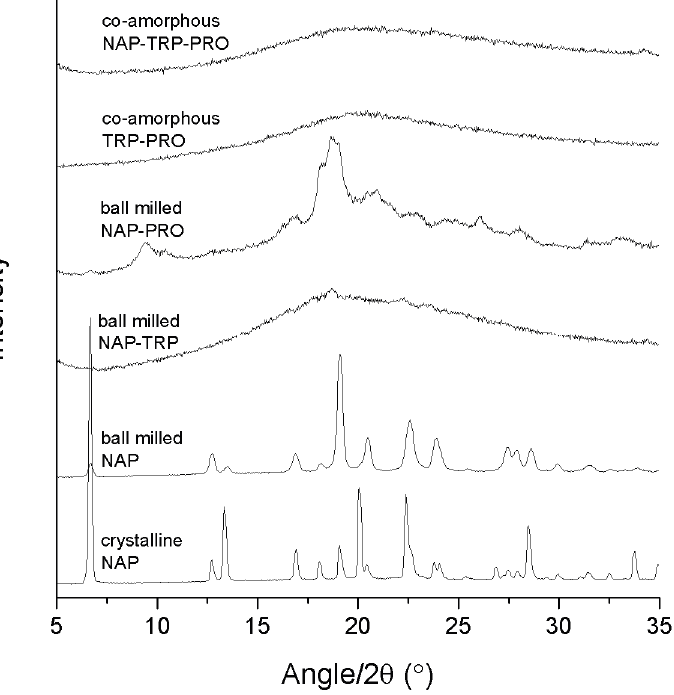
Figure 1. X-ray powder diffraction (XRPD) diffractograms of crystalline NAP, ball-milled NAP, ball-milled NAP–TRP, ball-milled NAP–PRO, co-amorphous TRP–PRO and co-amorphous